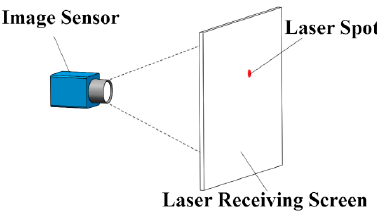
Figure 2. Image acquisition module.